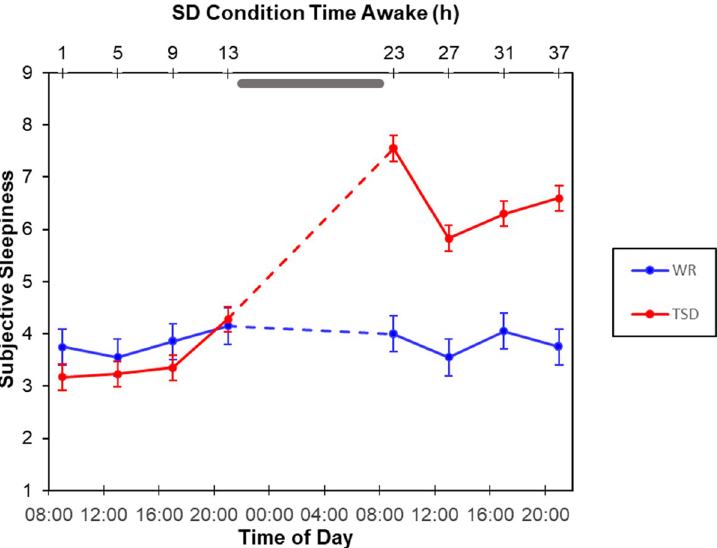
Fig 7. Subjective sleepiness ratings (mean ± SE) on the KSS for the TSD (red) and WR (blue) conditions. Grey bar represents sleep opportunity for WR condition and time awake for TSD